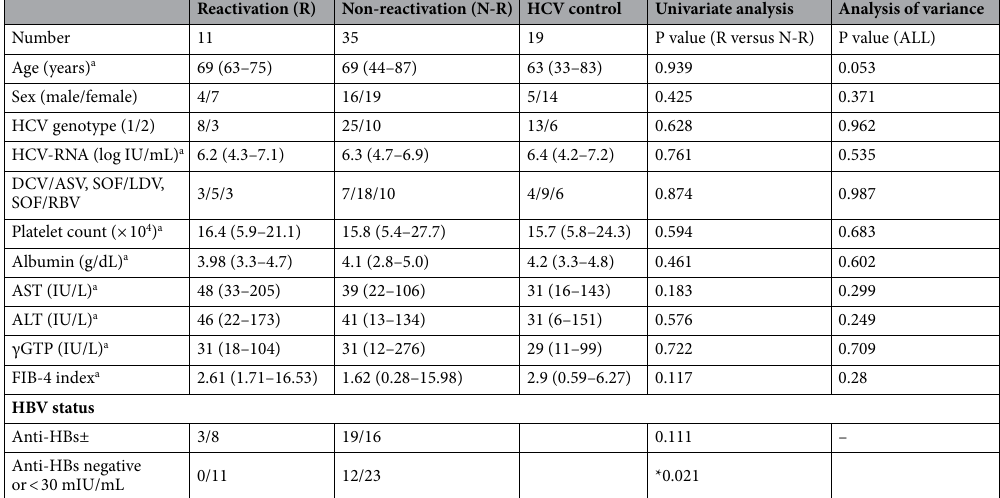
Table 1. Baseline characteristics of HCV-infected patients with or without resolved HBV infection. HCV hepatitis C virus; HBV hepatitis B virus, HCC hepatocellular carcinoma, AST aspartate aminotransferase, ALT alanine aminotransferase, γGTP γ-glutamyl transpeptidase, AFP a-fetoprotein, anti-HBs antibody to hepatitis B surface antigen. *Statistically significant difference, P < 0.05. a Data are shown as median (range)